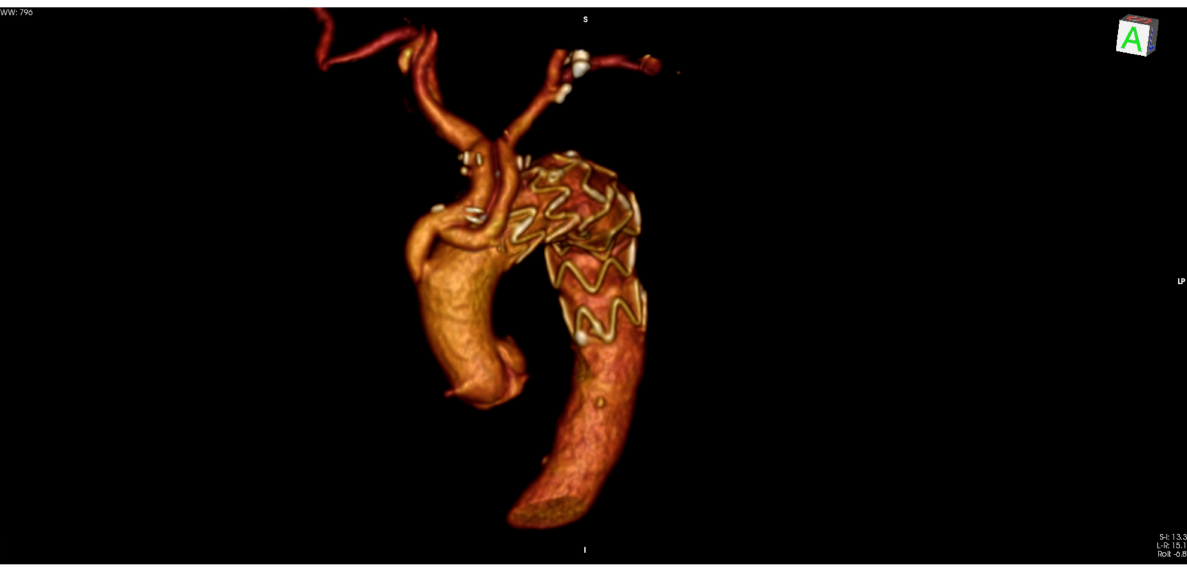
Figure 2. Three-dimensional (3D) angio-CT reconstruction of Zone 0 Type I Hybrid